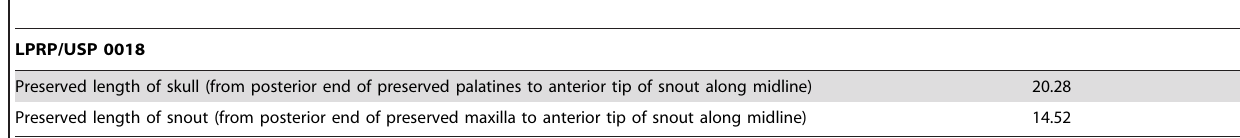
Table 2. Selected measurements (in cm) for the skull LPRP/USP 0018.